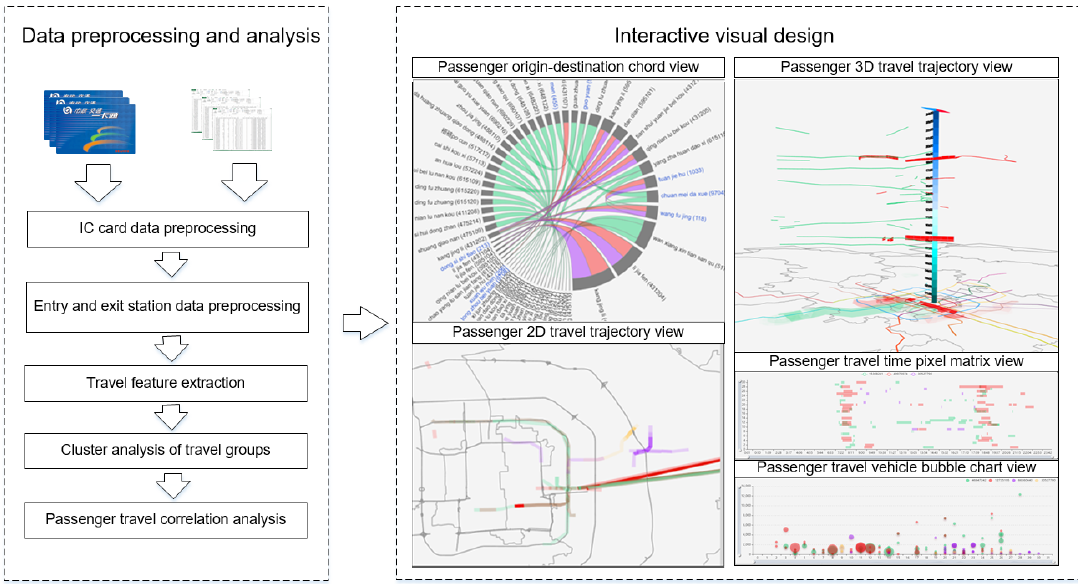
Figure 1. Multi-view interactive visual exploration of individual association for public transportation